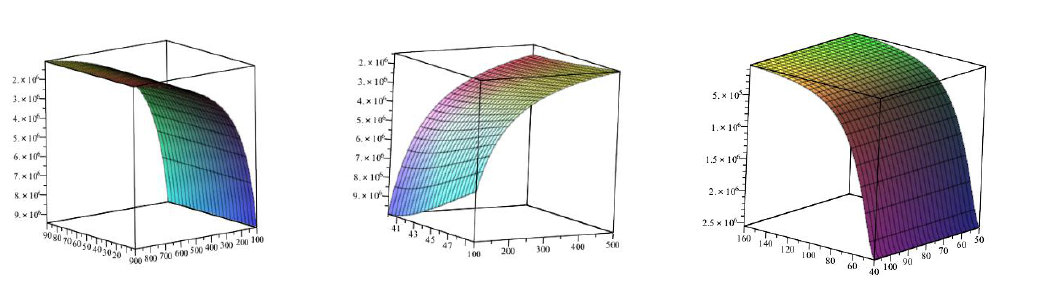
Fig. 3. Graphical representation of total profit